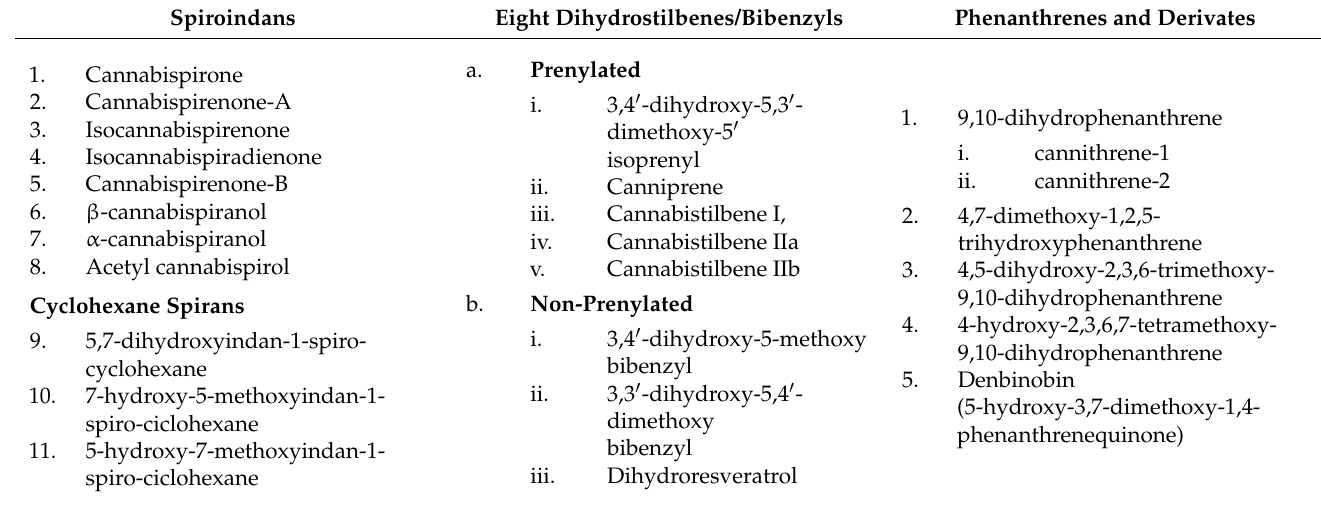
Figure 10. The chemical structure of dihydroresveratrol, a hydroxylated stilbene derivative. Nineteen stilbenoids unique to the cannabis plant were identified in a 1995 study by Ross and ElSohly [5]. These can be divided into three main structural classes: eleven spiroin- dans, eight dihydrostilbenes/bibenzyls, five phenanthrenes and prenylated, geranylated and glycosylated derivates [76]. Table 8 below is a list of these compounds. Table 8. Some stilbenes and their derivatives found in C. sativa